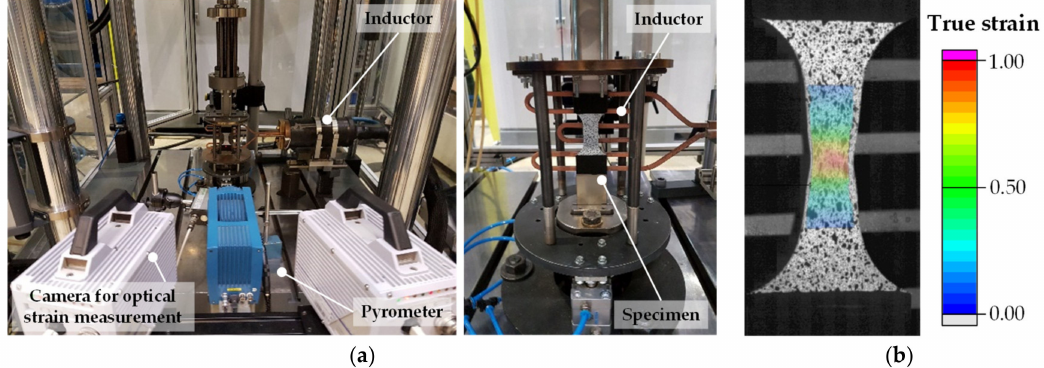
Figure 3. High-speed tensile tests for discrete temperatures and strain rates: ( a ) experimental setup with local inductive heating of the specimen area; ( b ) optical strain evaluation of an exemplary tensile test at 400 ◦ C and 1.0 s − 1 . The experimentally determined data points for a strain rate of 0.1 s − 1 were approxi- mated for each test temperature using Equation (1).